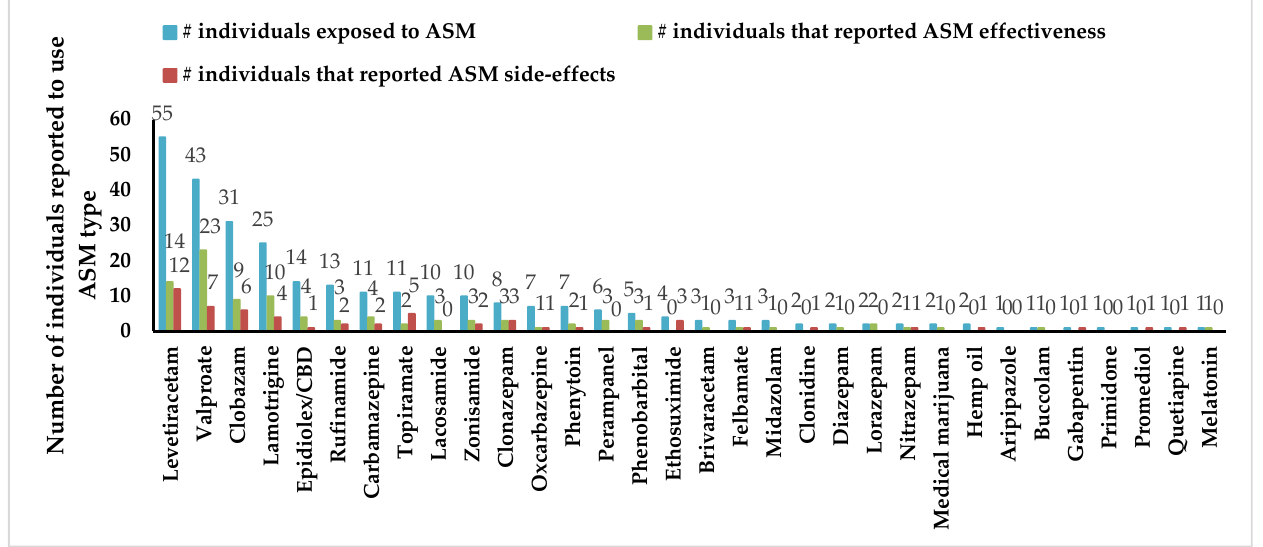
Figure A1. Profile of anti-seizure medications (ASMs) reported by caregivers in the treatment of individuals with MDS affected by seizures and the medication effectiveness.